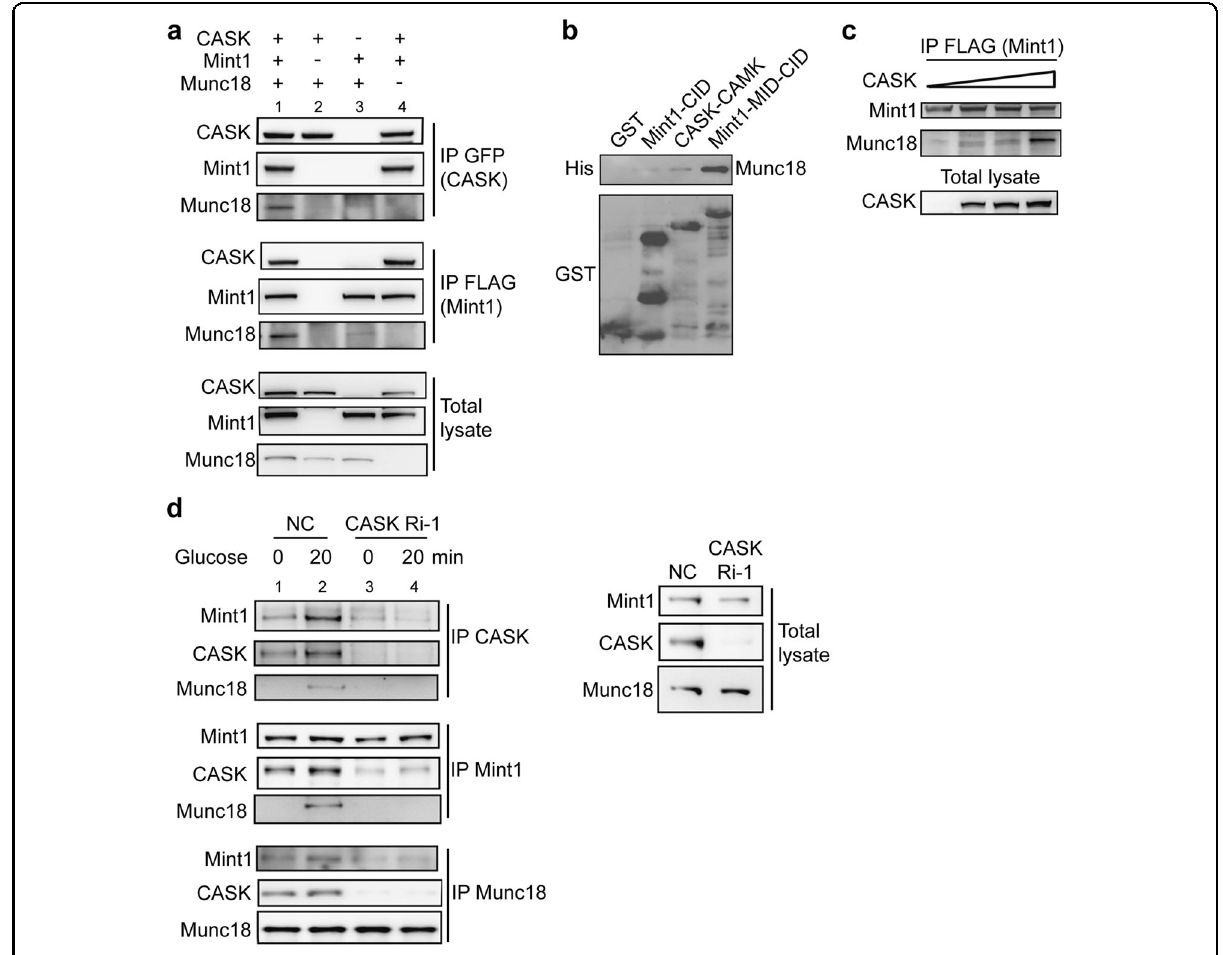
Fig. 3 CASK-Mint1 interaction facilitates CASK/Mint1/Munc18-1 complex formation. a Co-immunoprecipitation of overexpressed CASK-GFP, Mint1-Flag and Munc18-1 in 293 cells showed by western blot analysis. Immunoprecipitations (IPs) of CASK and Mint1 were carried out with anti-GFP or anti-FLAG ABs., respectively. b Munc18-1 bound to Mint1-MID-CID directly, but not to CASK-CaMK. Recombinant his-Munc18-1 was incubated with different fusion proteins of GST-CaMK (CASK), CST-Mint1-CID and GST-Mint1-MID-CID (lower panel) as indicated. Upper panel, his-Munc18-1 detected by western blot with anti-his AB. Lower panel, different GST-fusion proteins detected by WB with anti-GST AB. c Co-immunoprecipitation of exogenous CASK, Mint1-Flag and Munc18-1 with anti- fl ag antibodies when CASK was expressed at different levels in 293 cells. For a and c , anti-tag antibodies were used to detect the proteins co-immunoprecipitated with CASK or Mint1. d The effect of CASK-depletion on the formation of CASK/ Mint1/Munc18-1 tripartite complex in native INS-1E cells stimulated with glucose. Left panel, western bolt analysis for detection of the formation of CASK/Mint1/Munc18-1 complex precipitated by IPs with CASK, Mint1 and Munc18 antibodies. Right panel, expression of CASK, Mint1 and Munc18 revealed by western bolt analysis. Ri-1: CASK-speci fi c siRNA; NC: non-silencing control